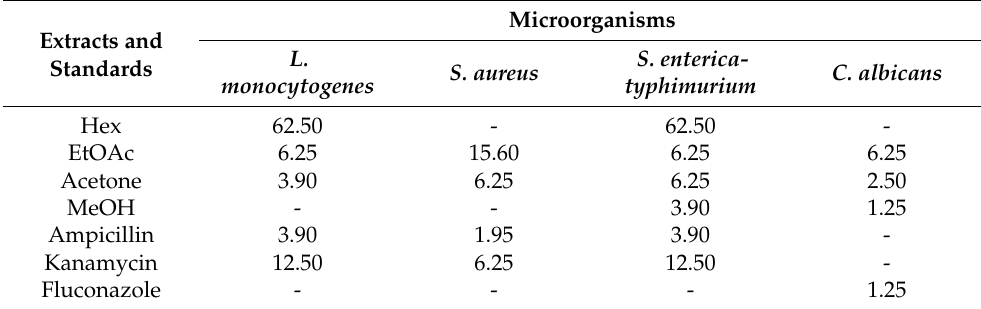
Table 7. Minimum Inhibitory Concentrations (MICs), expressed in µ g · mL − 1 , of Erodium arborescens aerial part extracts compared to three standards (ampicillin, kanamycin and fluconazole) against L. monocytogenes , S. aureus , S. enterica-typhimurium and C. albicans